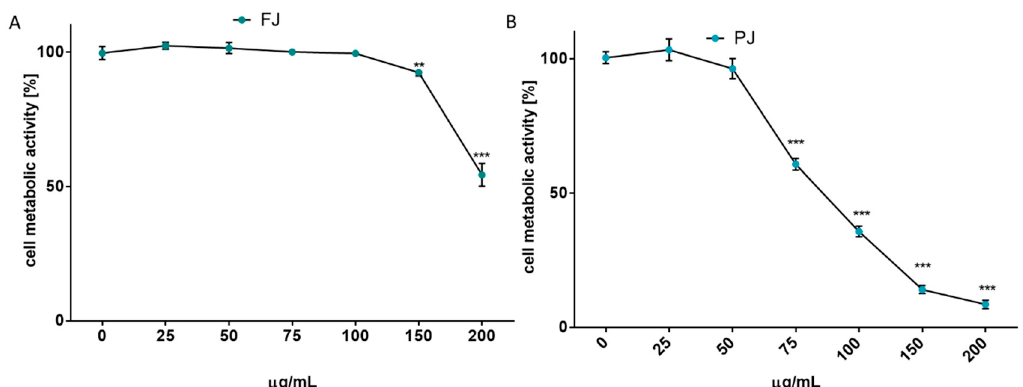
Figure 2 . The influence of V. opulus on Saos-2 cell metabolic activity, determined by Presto Blue reagent after 48 h exposure with FJ ( A ) and PJ ( B ); control cells were not exposed to any compound; values are means ± SEM, n ≥ 12; statistical significance was calculated versus control cells (untreated), ** p ≤ 0.01, *** p ≤ 0.001.